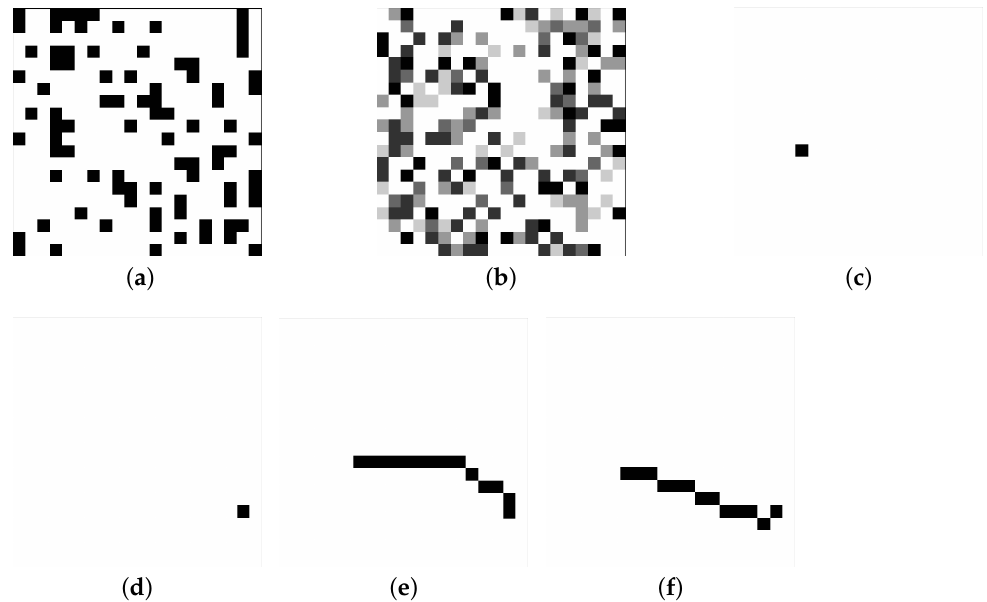
Figure 1. Six dimensions of a map data ( a ): Obstacle map; ( b ): Traversable cost map; ( c ): Starting point map; ( d ): Ending point map; ( e ): Lowest cost path map; ( f ): Shortest path